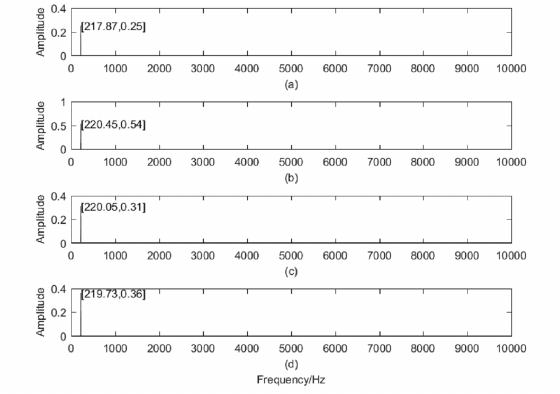
Figure 6. ( a ) FFT of new tool wear, ( b ) FFT of severe wear, ( c ) FFT of tool breakage, ( d ) FFT after tool